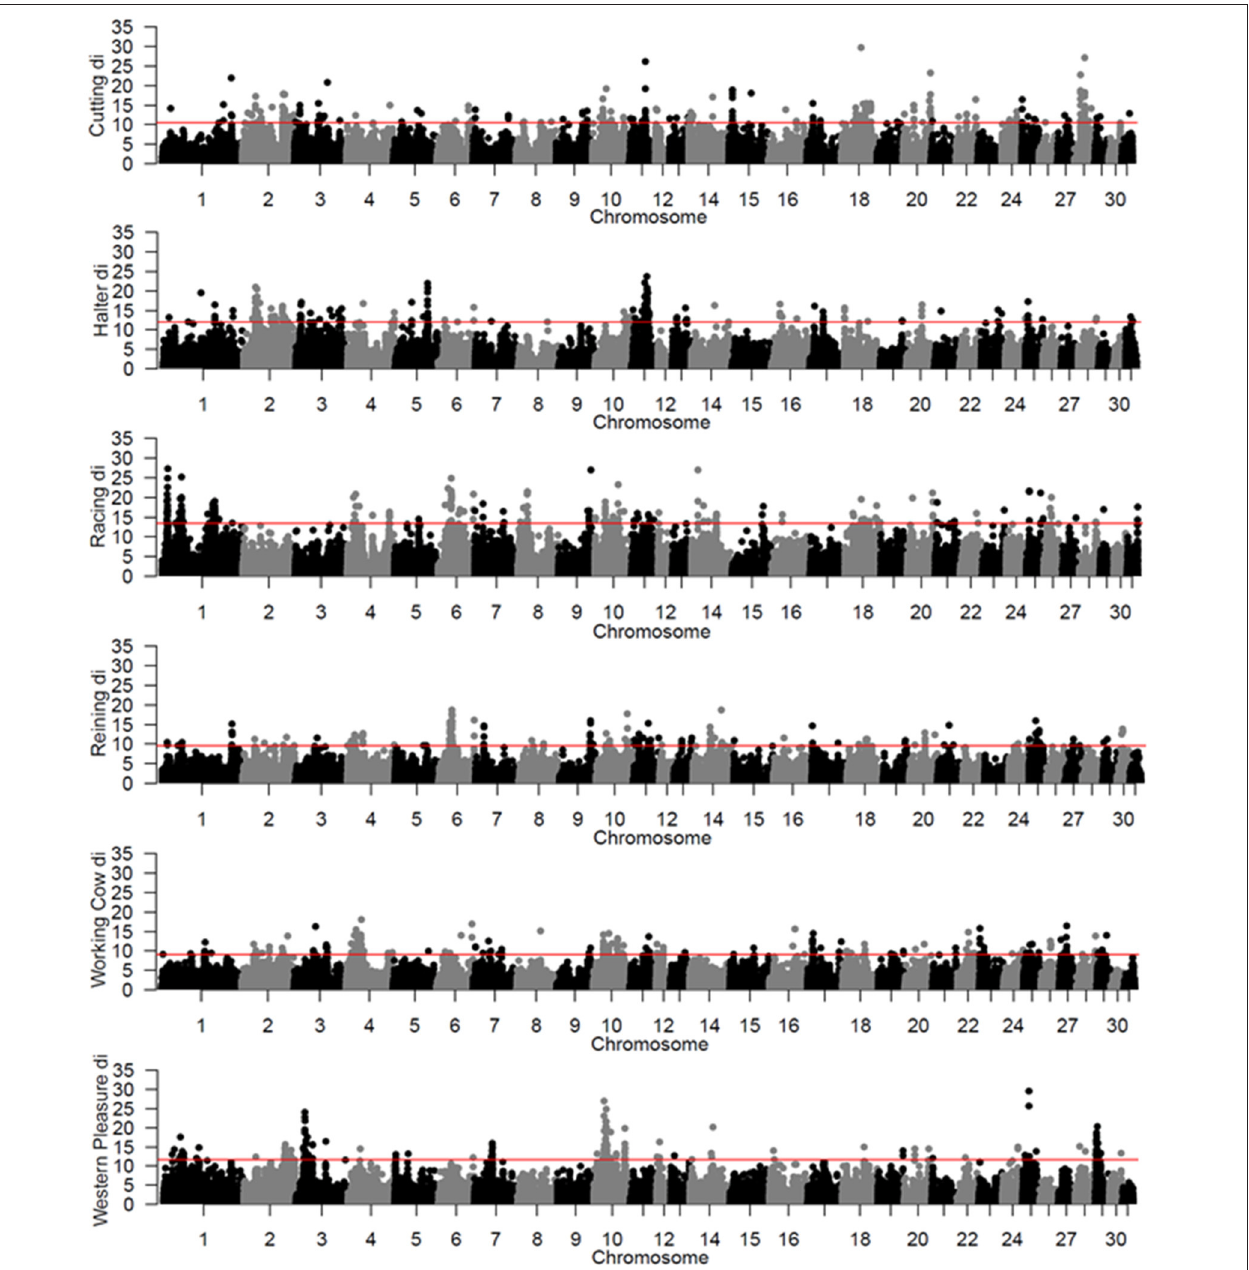
FIGURE 1 | Genome-wide d i values for the 6 QH subpopulations. Each d i value is plotted on the y axis and each autosome is shown on the x axis in alternating colors. Each point represents a 10kb window. The red horizontal line represents the top 0.1% of the empirical distribution of d i for each QH subpopulation.